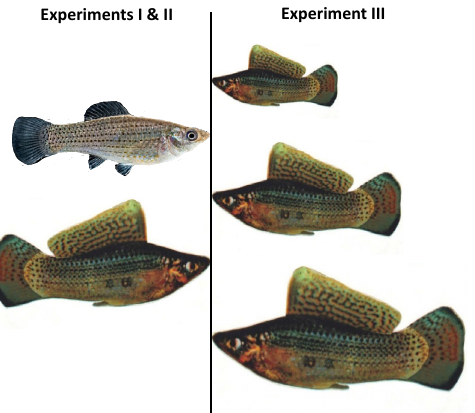
Figure 1. Dummy fish stimuli. ( Left ) Images used to create the 60 and 50 mm in total length male and female dummy stimuli used in all behavioral assays for expts. I and II; ( Right ) Images used to create the 40, 60, and 80 mm in total length male dummies used in all behavioral assays for expt. III.